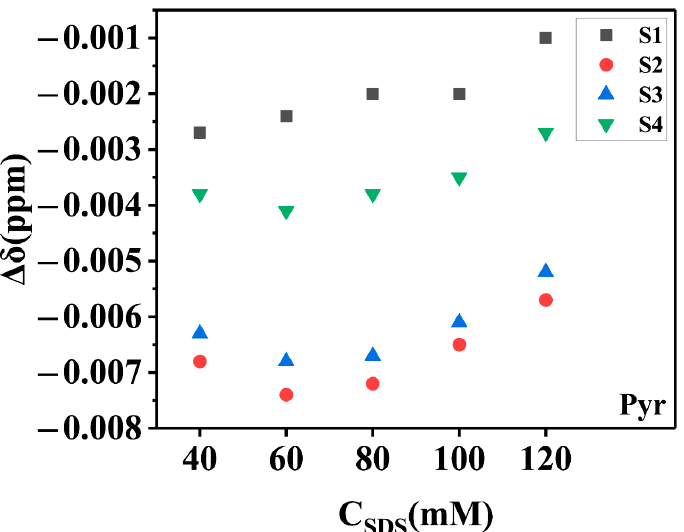
Figure 10. Relative chemical shifts ( ∆δ ) of SDS protons in the single Pyr solubilization system at SDS concentrations from 40 to 120 mM compared to those of the pure SDS solution at the same concentration.